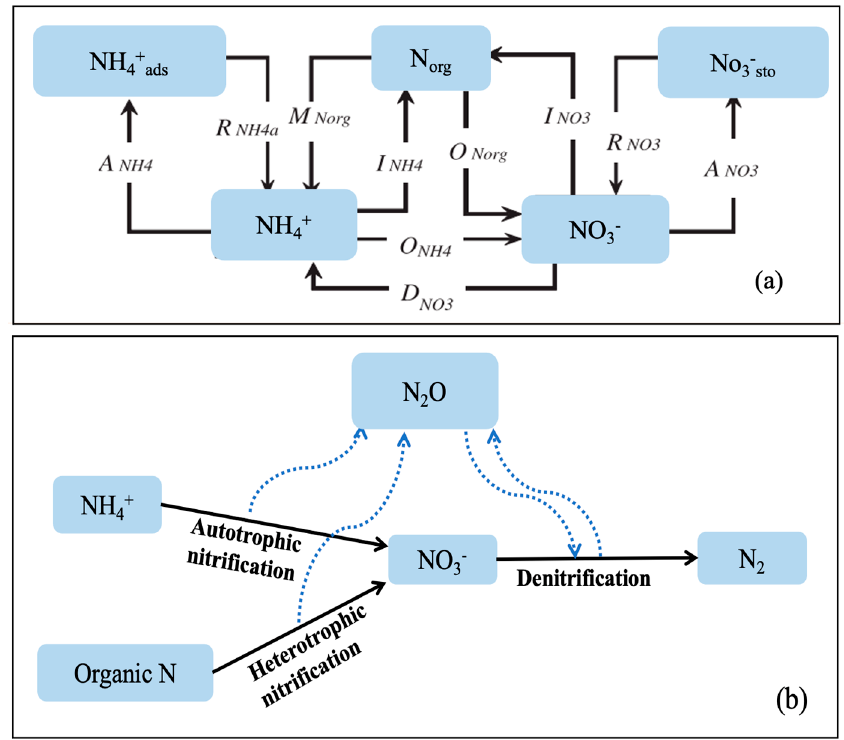
Figure 1. The 15 N tracing model used to determine gross N transformation rates ( a ) [24] and N 2 O production pathways from specific N pools ( b ). N org : soil organic N (including soil labile organic N and recalcitrant organic N), NH 4+ : ammonium, NO 3 − : nitrate, NH 4+ads : ammonium adsorbed to soil, NO 3 − sto : stored nitrate, SOM: soil organic matter. Abbreviations for the transformations are as in Table 2. The initial pool sizes for soil NH 4+ -N and NO 3 − -N were estimated by extrapolating the first two sets of data back to the time point zero [27]. Based on the kinetic settings and the final parameters set, average gross transformation rates were then calculated over the whole incubation period and presented in units of μ g N g − 1 soil d − 1 (Table 2).